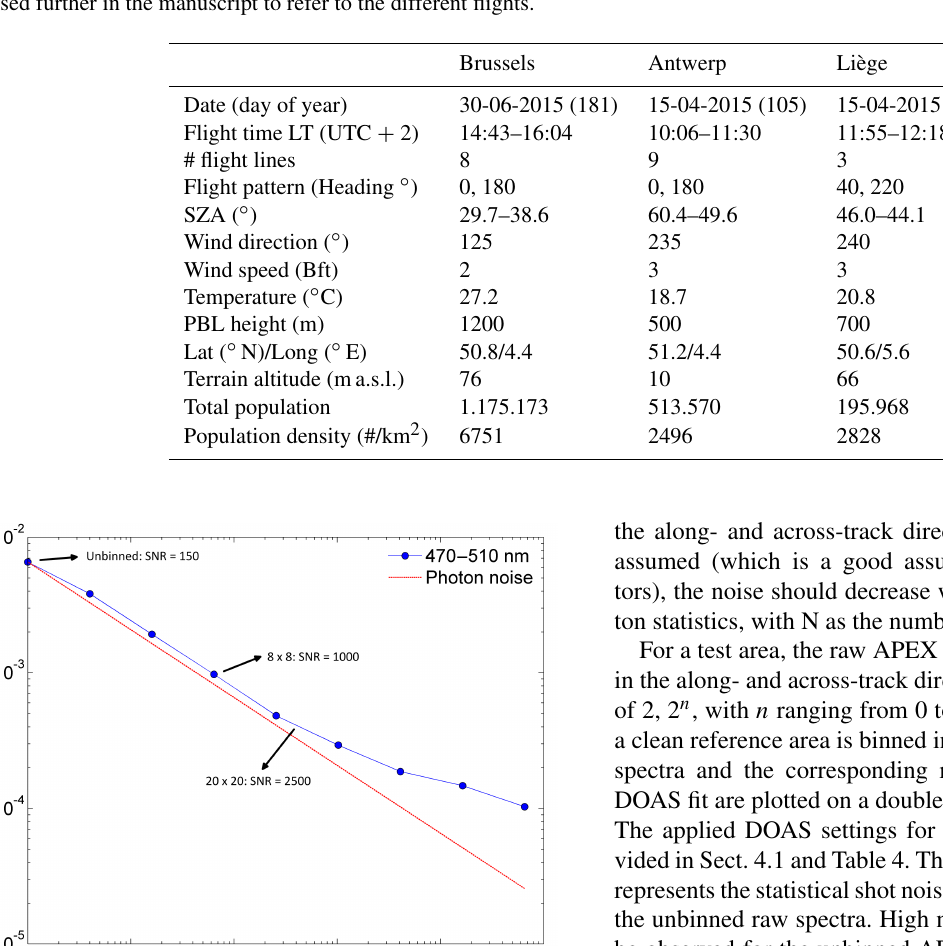
Table 2. Acquired data sets and flight characteristics. Wind and temperature data are collected from weather stations of the Royal Mete- orological Institute (RMI) and averaged over the time of flight. Population data from 1 January 2015 is retrieved from Statistics Belgium: http://statbel.fgov.be/, last access: 15 January 2016. For each flight, the day number of the year 2015 is mentioned between brackets and will be used further in the manuscript to refer to the different flights.